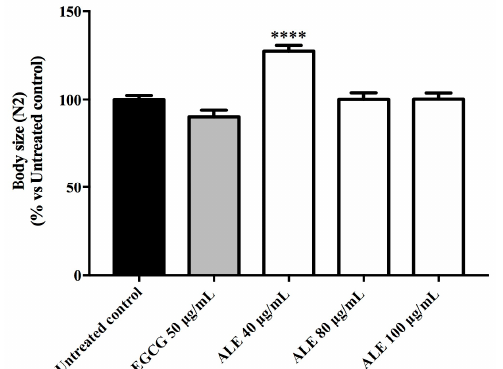
Figure 7. Effect of Uncaria tomentosa leaf extract on the body size of the N2 worms. The control groups were the untreated worms and the worms pre-treated with commercial green tea EGCG at 50 µg/mL. Each bar represents the relative mean ( n = 30) area ± SEM from three independent assays. The asterisks indicate the statistical differences (vs untreated worms) according to one-way ANOVA followed by a post-hoc Tukey’s test: **** p < 0.0001.